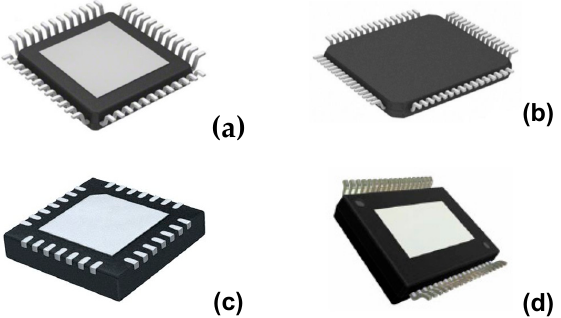
Figure 1. Bottom side views of specimens of the ( a ) eLQFP, ( b ) pLQFP, ( c ) single-row eQFN, and ( d ) PowerSSO-36 package families.